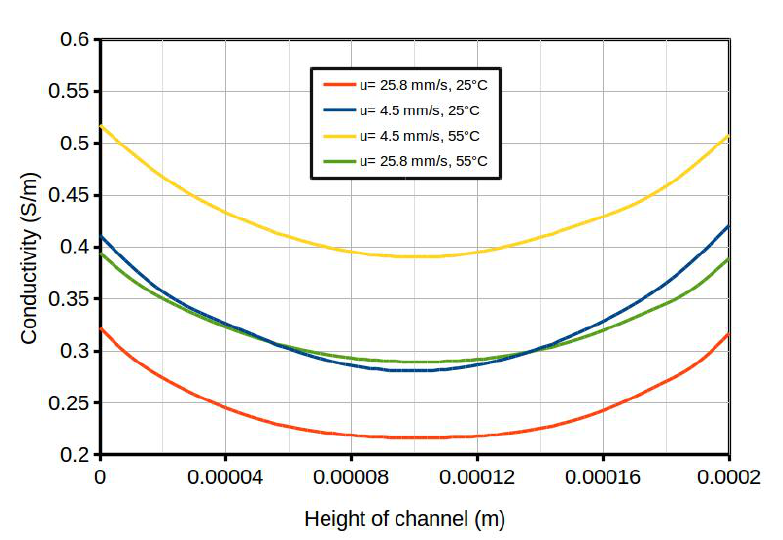
Figure 7. Conductivity versus the height of the channel (the a − − b cross-section in Figure 5a) at X = 0.0108 m from the inlet of the dilute channel at two different inlet average velocities (u = 4.5 and 25.8 mm ) and T = 25 ◦ C and T = 55 ◦ C, resulting in four different Re numbers: Re =1, 1.8, 5.7, and s